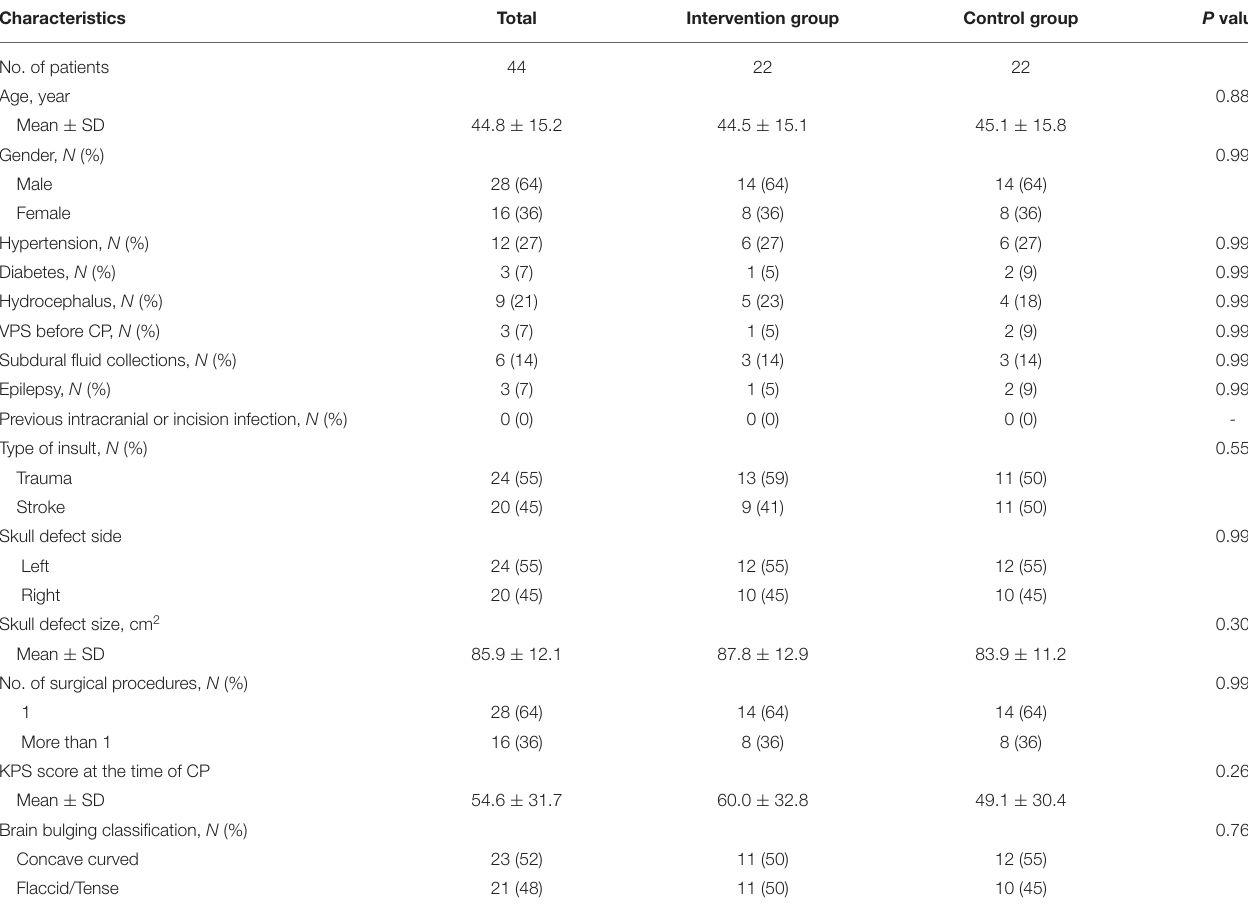
TABLE 1 | Baseline characteristics of patients.